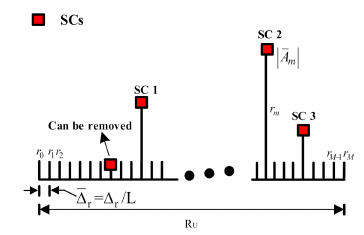
Figure 1. Diagram of the distribution of